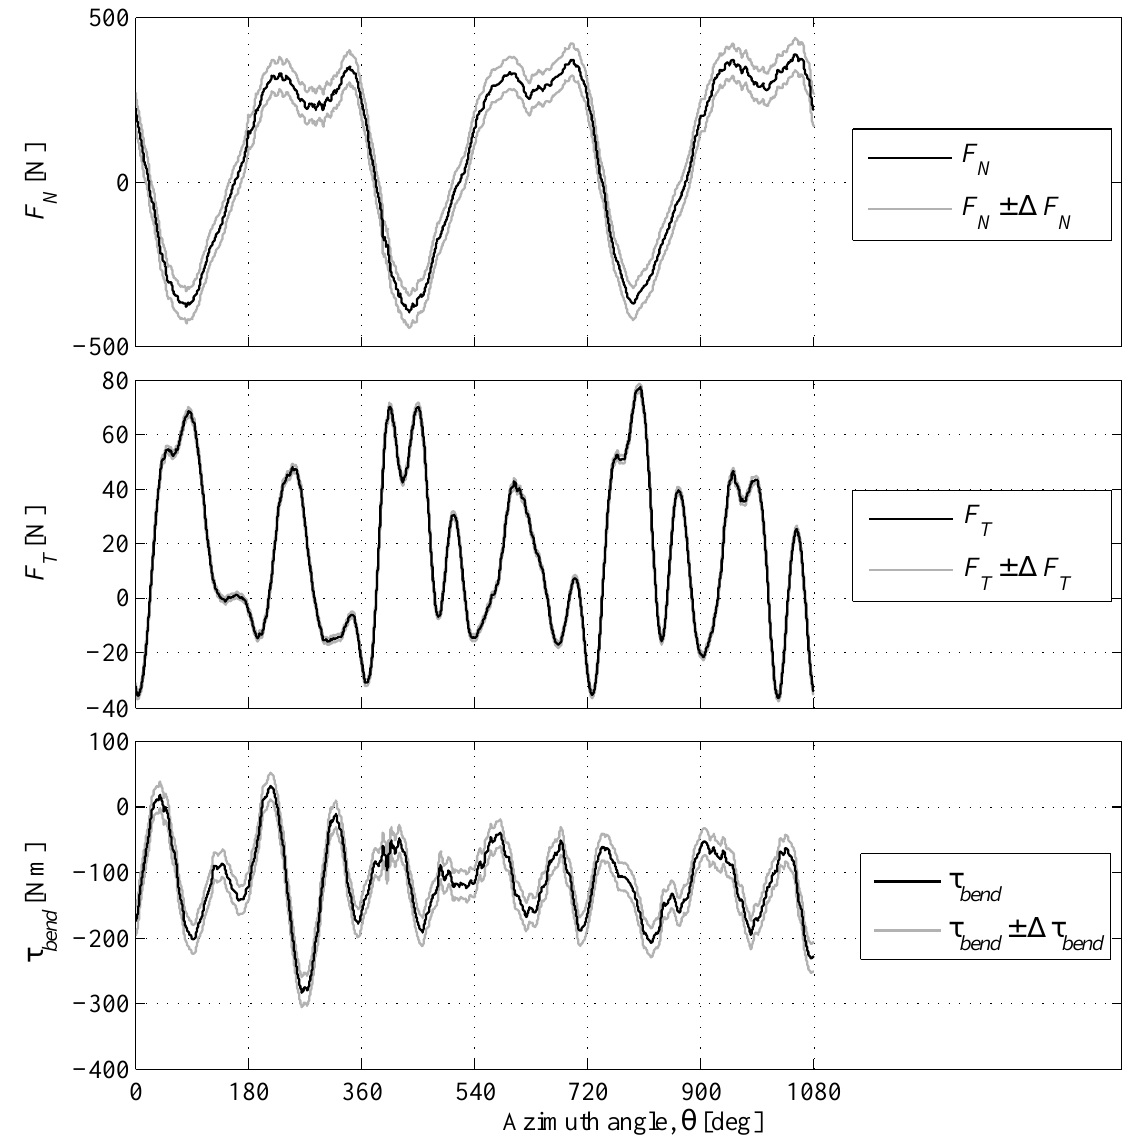
Figure 9. Estimations of F Tip speed ratio λ = 4 . 31 , (cid:104) Ω